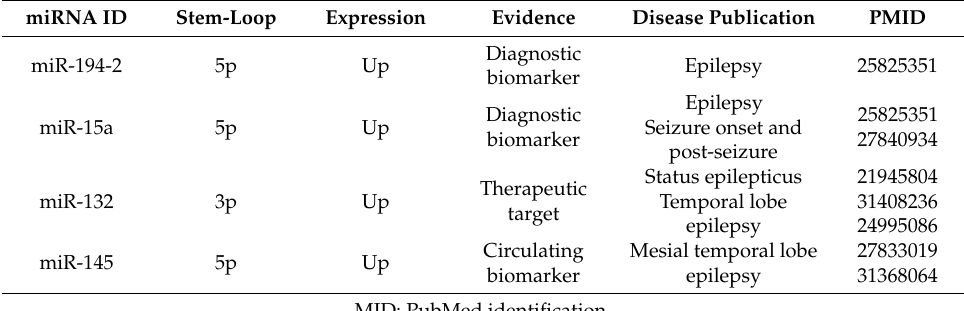
Table 2. Profiles of four identified target miRNAs in serum exosomes from patients with FCD.